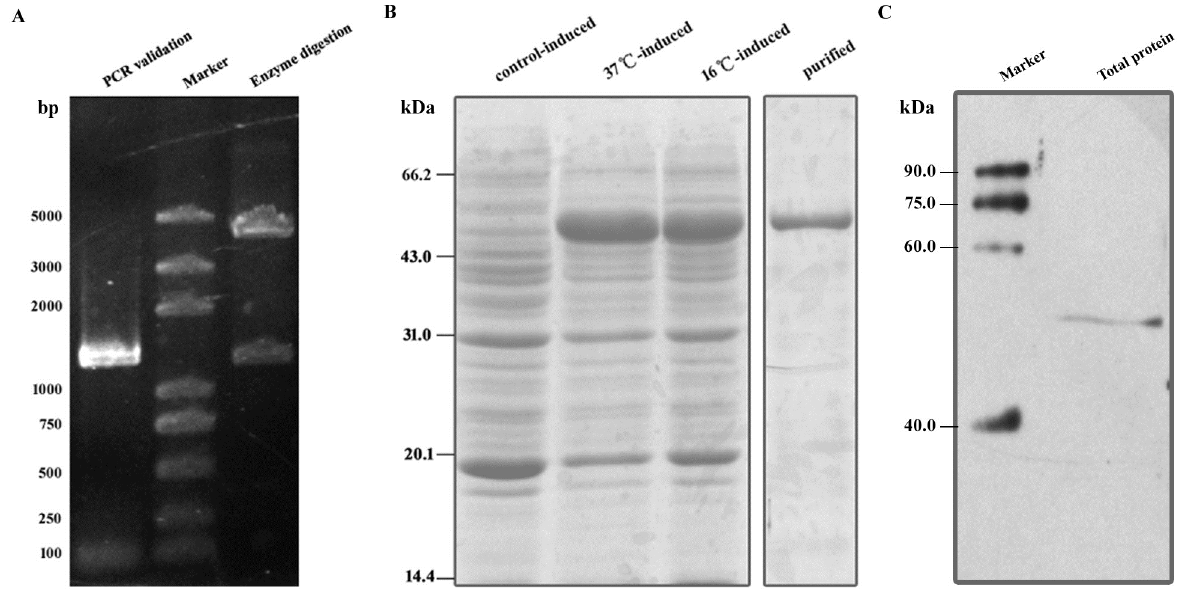
Fig 1. Expression of β -Tubulin. (A) Validationof pColdI- β -tubulin vector by PCR and Bam HI/Sal I enzyme digestion. ~1300 bp products were amplifiedby PCR or cleavedfrom recombinant vector. (B) SDS-PAGE of proteinsexpressedin Escherichiacoli Rosetta. Recombinant β - Tubulinprotein was inducedto express at 37˚C and 16˚C. pCold I vector transformed E . coli Rosetta were inducedfor expressionat 37˚C as a control. (C) Immunoblotfor β - Tubulinin total protein of Nosemabombycis mature spore. The antibody recognized a 50 kDa band which was consistentwith prediction.